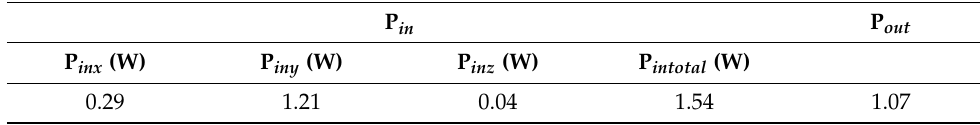
Table 4. Measured values of input power Ref. [16].